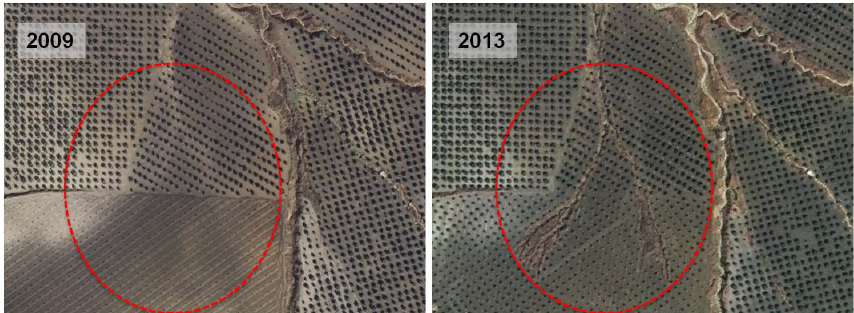
Figure 3. Example of orthophotos showing gully incision between 2009 and 2013 from an old (left panel) into a new plantation (right panel).